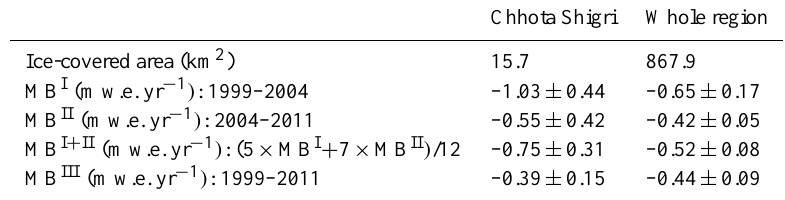
Table 5. Geodetic MB during 1999–2004, 2004–2011 and 1999–2011. All values in this table are calculated using the correction and error analysis proposed by Gardelle et al. (2012a, b). For each time interval, all valid DEM pixels are used contrary to Table 5 below, in which only pixels that are valid simultaneously in all three DEMs are used.